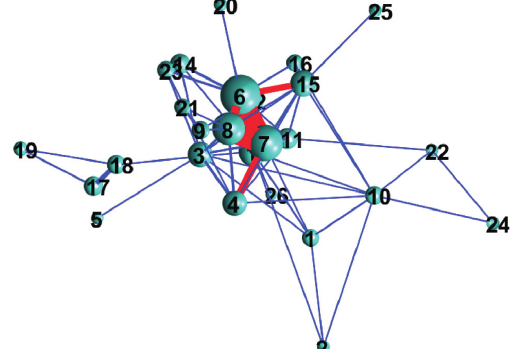
Figure 9: Magnified network plot of the equilibrium state from another directional view for “Romeo and Juliet.” Large-sized nodes are linked together with thicker lines, and small-sized nodes are linked with thinner lines and located around the large-sized